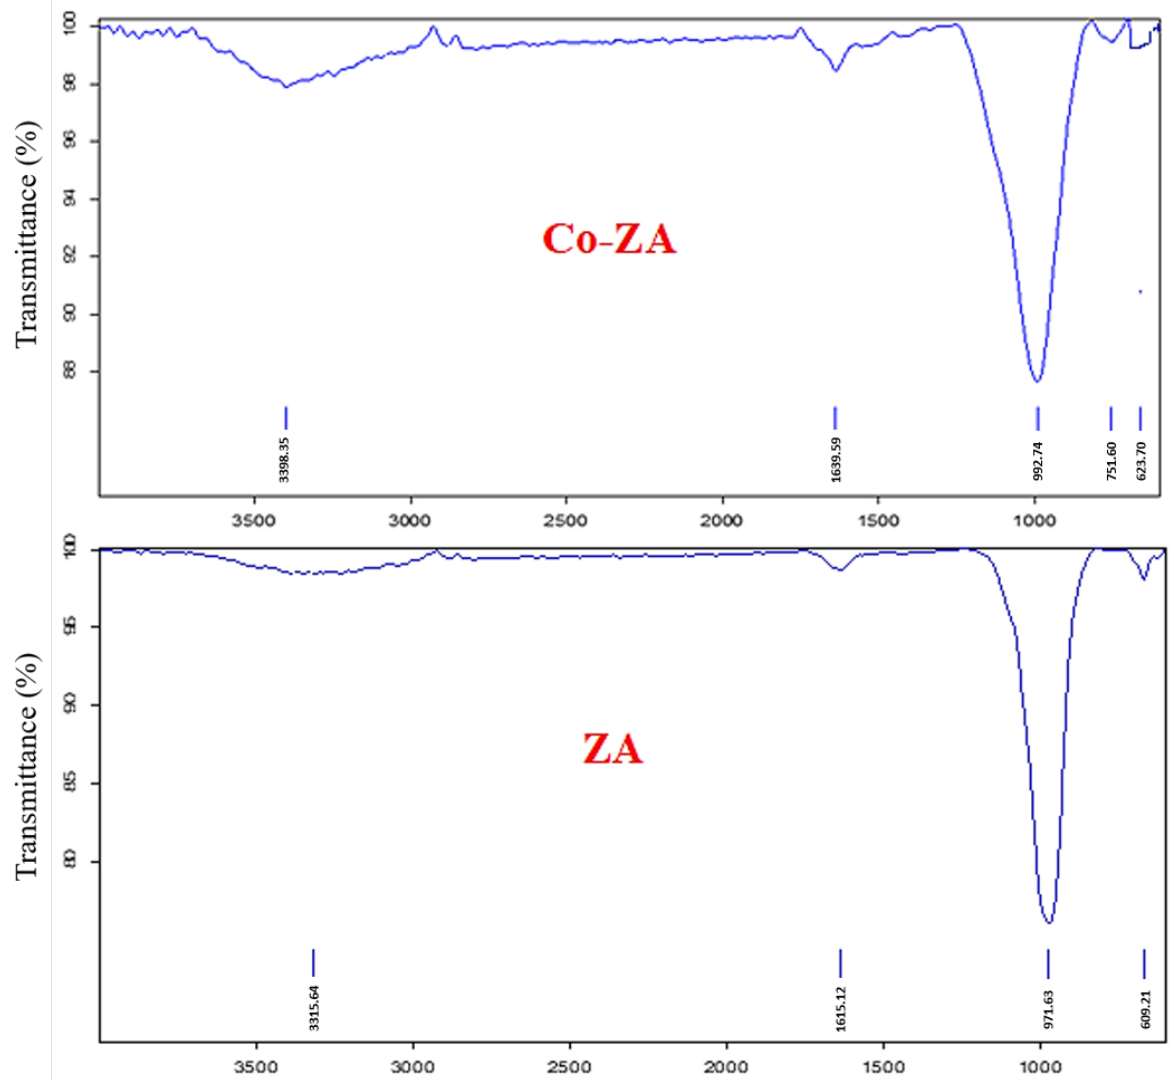
Figure 3. FTIR of the synthesized